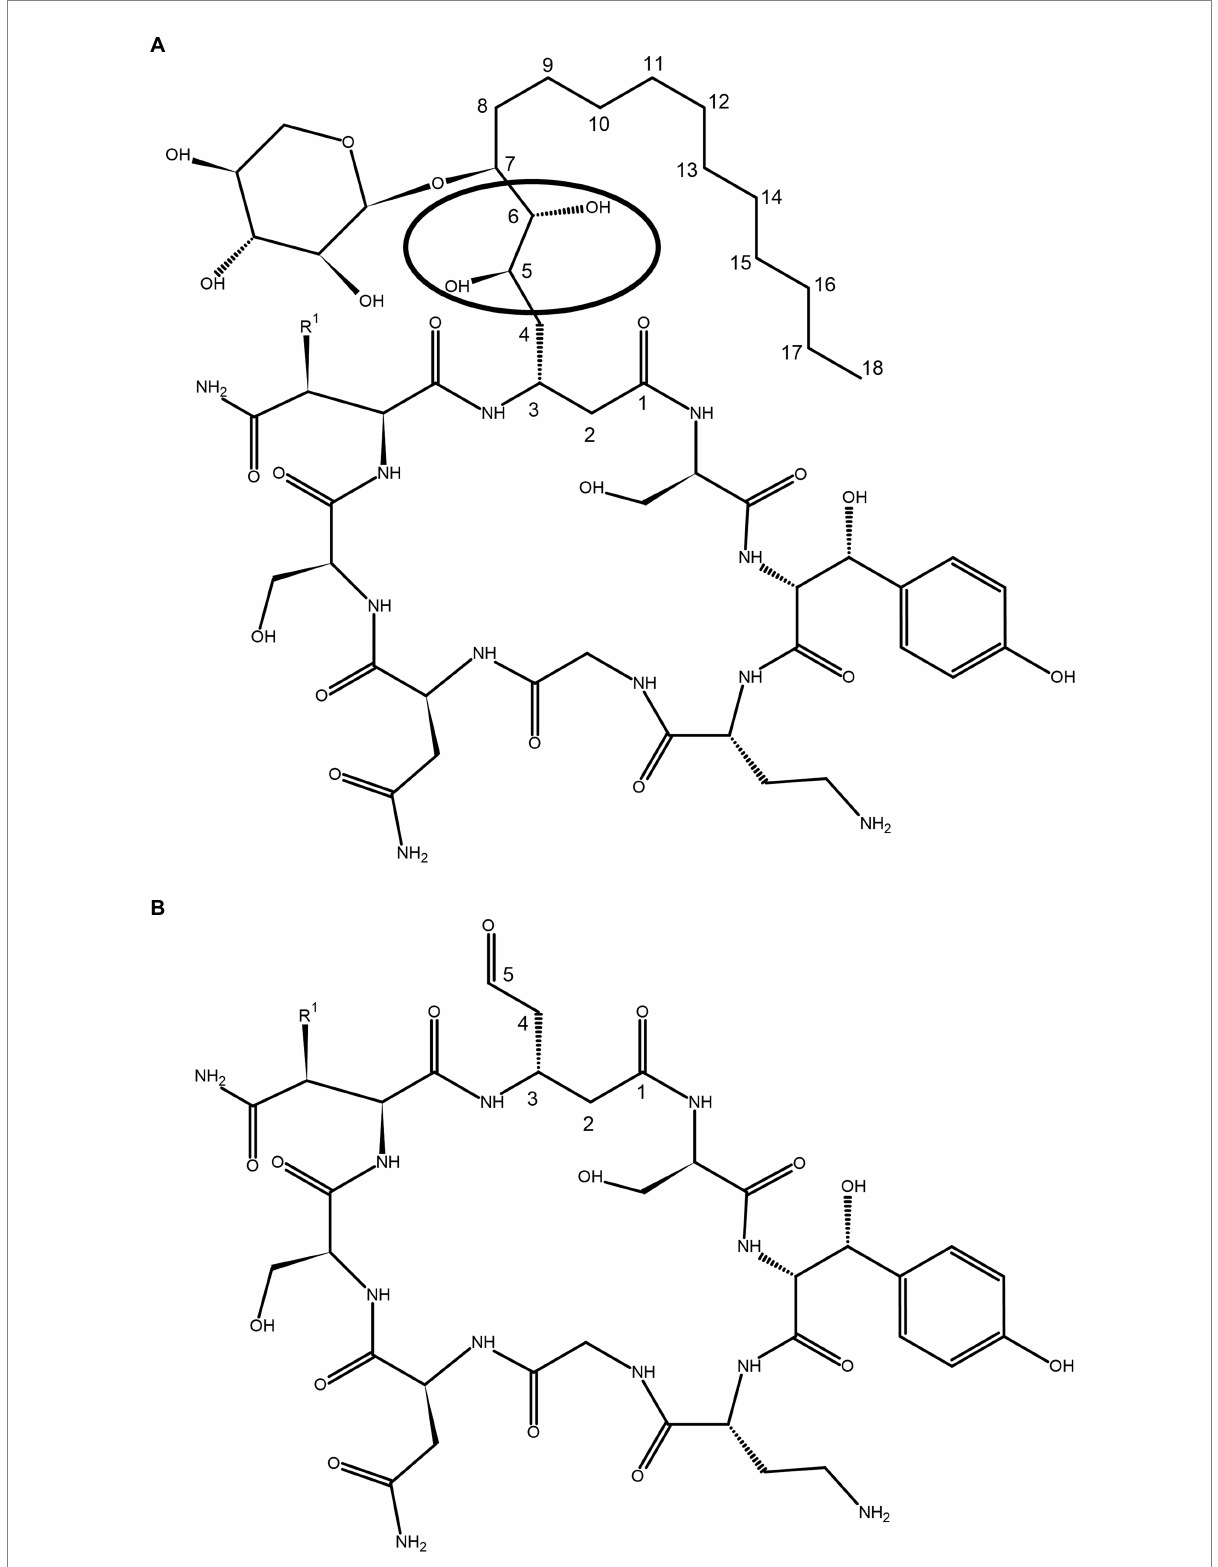
FIGURE 1 Covalent structure of (A) occidiofungin and (B) aldehyde analog. The circle indicates the position of the diol group where the oxidative cleavage occurs. The carbons in the novel amino acid (NAA) are numbered based on the carbonyl group of NAA labeled as carbon one C (1). R1 is a proton or hydroxyl group, representing the natural occurrence of an asparagine and beta hydroxy-asparagine variants of